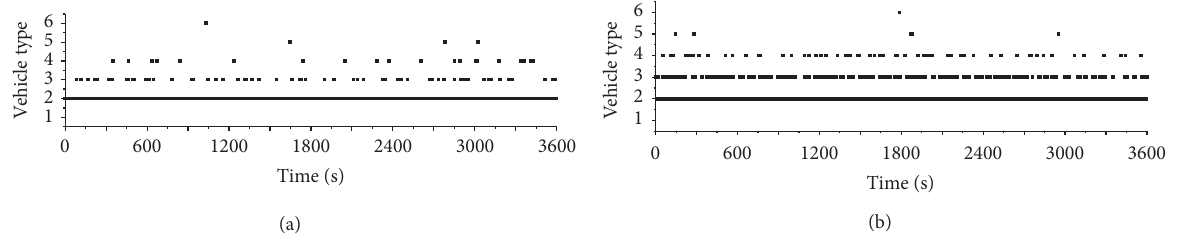
Figure 9: Traffic flow from 9:00 to 10:00: (a) north net data; (b) south net data.